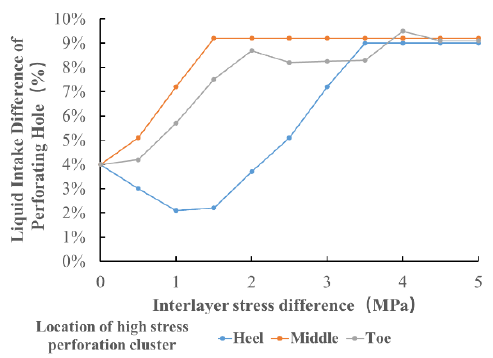
Figure 7. Liquid inflow difference of multiple clusters of cracks under different stress differences between clusters.